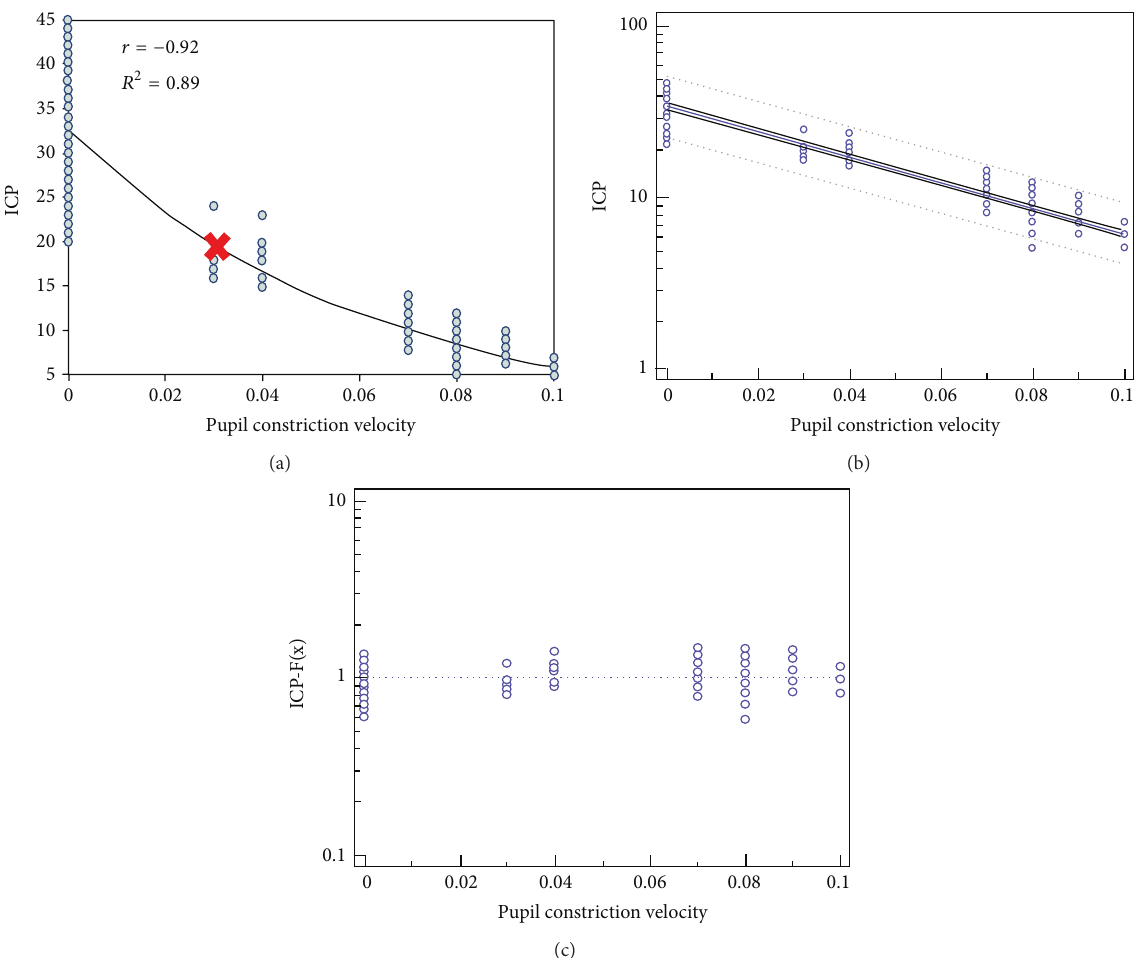
Figure 8: (a) Pupil constriction velocity ( 𝑉 ) in cm/s plotted versus the ICP (mmHg); the scatter plot displays a negative exponential relation (red ribbon corresponds to ICP = 20 mmHg) between the two parameters rather than an exact linear relation. (b) Regression analysis model: the “dots” represent the actual measured values, while the blue line in the middle represents the estimated values by the model and the dashed lines represent 95% confidence intervals. (c) Goodness of fit for the model-driven prediction equation calculating the proximity of the predicted values (dots) to the actual measured values (dashed blue